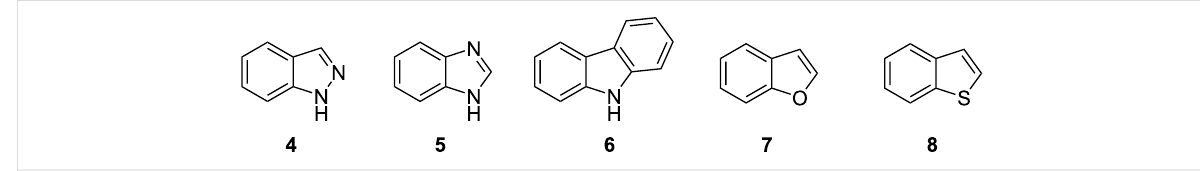
Figure 3: Structures of heterocycles that did not react with ketone 2a .